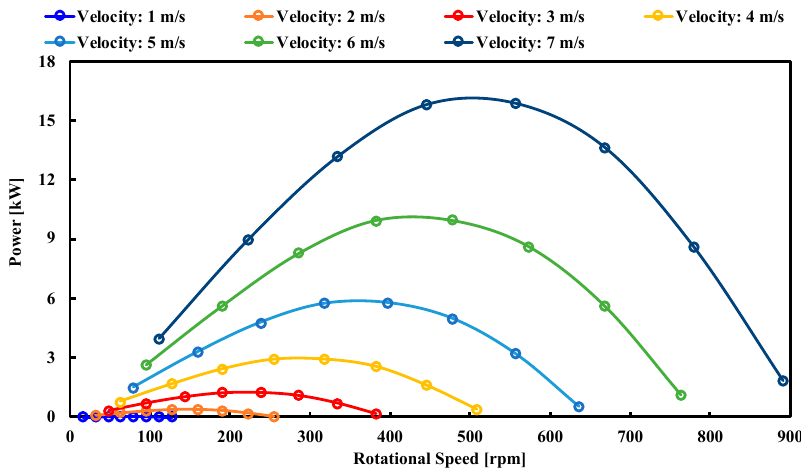
( c ) Figure 14. Velocity distribution mid span of the flow passage for various TSR : ( a ) TSR = 1.0; ( b ) TSR = 2.5; ( c ) TSR = 4.0. 6. Generator and Turbine Running Characteristics Figures 15 and 16 show the distribution of output power and drag force at various RPM, for a range of TSR from 0.5 to 4. It can be observed that for a given velocity, the blade torque at zero is directly proportional to the rotational speed. On the other side, with an increase in rpm, the drag force increases for given inlet velocity as inferred in Figure 16. Measured mechanical load input and electrical load output distribution against different RPM, for impedance range of 4.7–34.9 Ω , are shown in Figure 17 and Figure 18. For a given voltage, the low and high impedance implies low and high resistance, respectively. It is noticed that the mechanical and electrical power output decrease with an increase in impedance for a given voltage. On the other side, the electrical power out is slightly low as compared to the mechanical power input due to transmission loss. Subsequently, two different impedances of 4.7 Ω and 34.9 Ω are adopted for further studies. By incorporating these two impedances in Figure 15, the unique correlation between